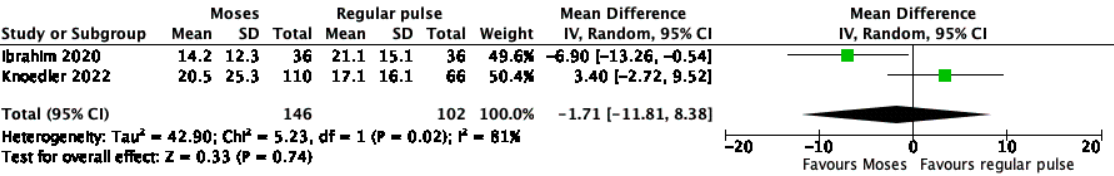
Figure 3. Forest plot of the meta-analysis comparing operative time between Moses versus regular pulse modulation [18,35,37].